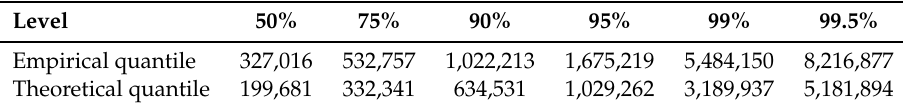
Table 5. Comparison between empirical quantiles and Lognormal–Burr ones.